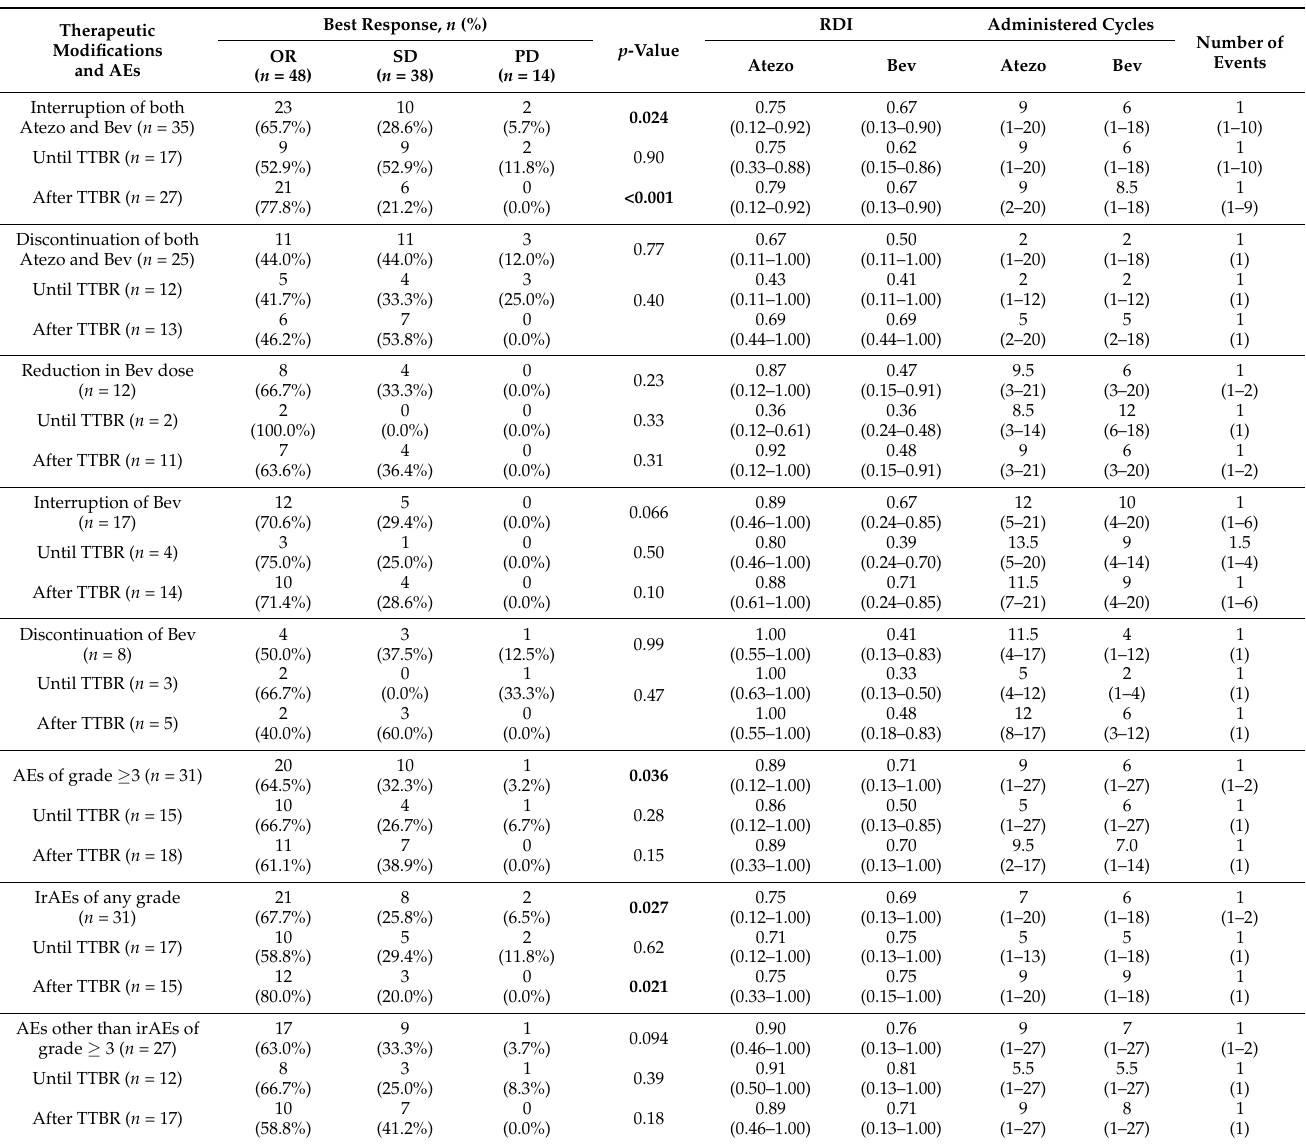
Table 2. Relationships between best response, therapeutic modification, and AEs experienced during TTP, until, and after